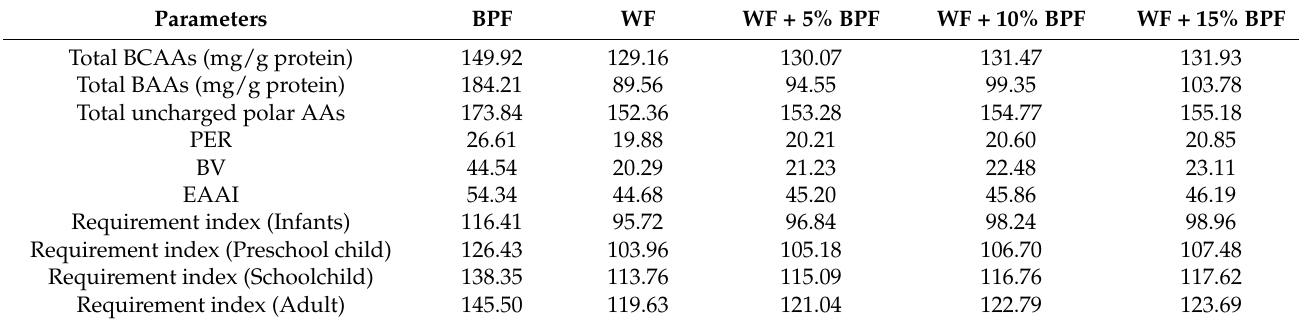
Table 6. Percentage of amino acids and calculated biological efficiency, essential amino acid index, estimated protein efficiency ratio, and requirement index of different age